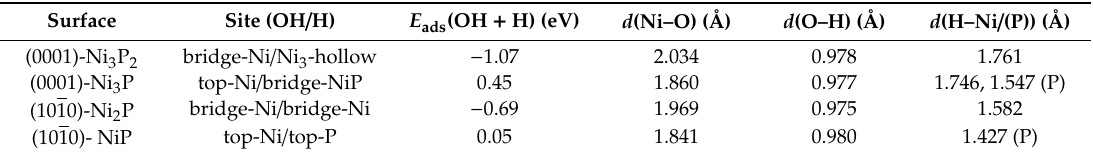
Figure 5 . The initial (IS) ( a – d ), transition (TS) ( e – h ), and final (FS) ( i–l ) states of the most favourable path for water dissociation on the (0001) and (1010) surfaces of Ni 2 P. Table 2. Dissociative adsorption energies (E ads ) and bond lengths (d) for water on Ni 2 P (0001) and (1010) surfaces. H-P bond distances are denoted as